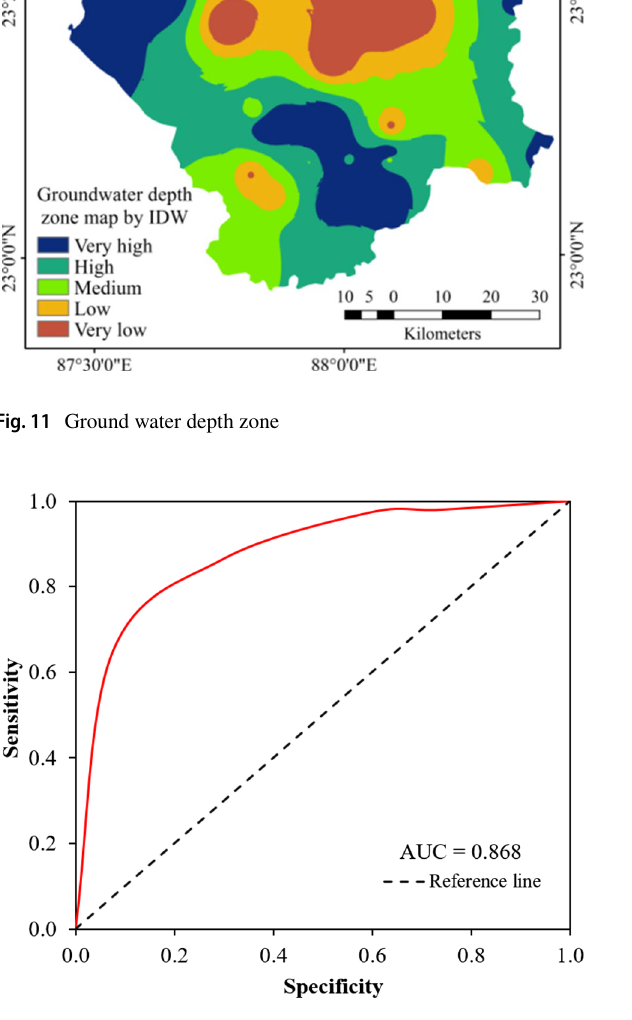
Fig. 12 Receiver operating characteristic (ROC)